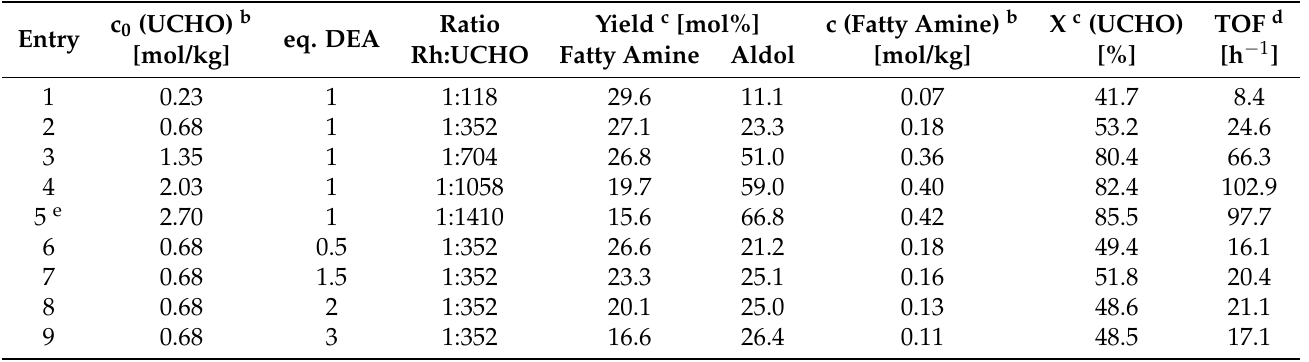
+ co-solvent), 12g water, α =0.5, γ =0.08 Marlophen NP8, 1wt% Na 2 SO 4 , 1200rpm, t =4h. b based on the total mass of the reaction mixture. c Determined after 4h with GC, nonane as external standard. d Determined at a reaction time of 30min. e Organic phase: 12g undecanal, no